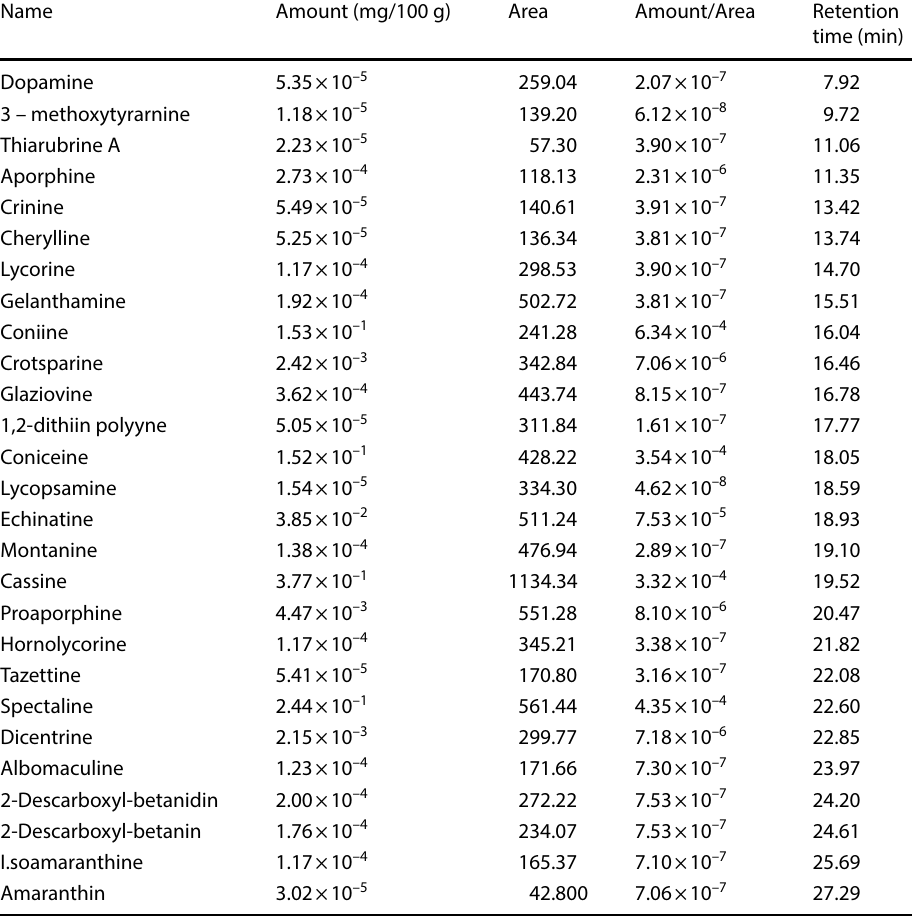
Table 7 Names and amount of the various alkaloids present in dichloromethane